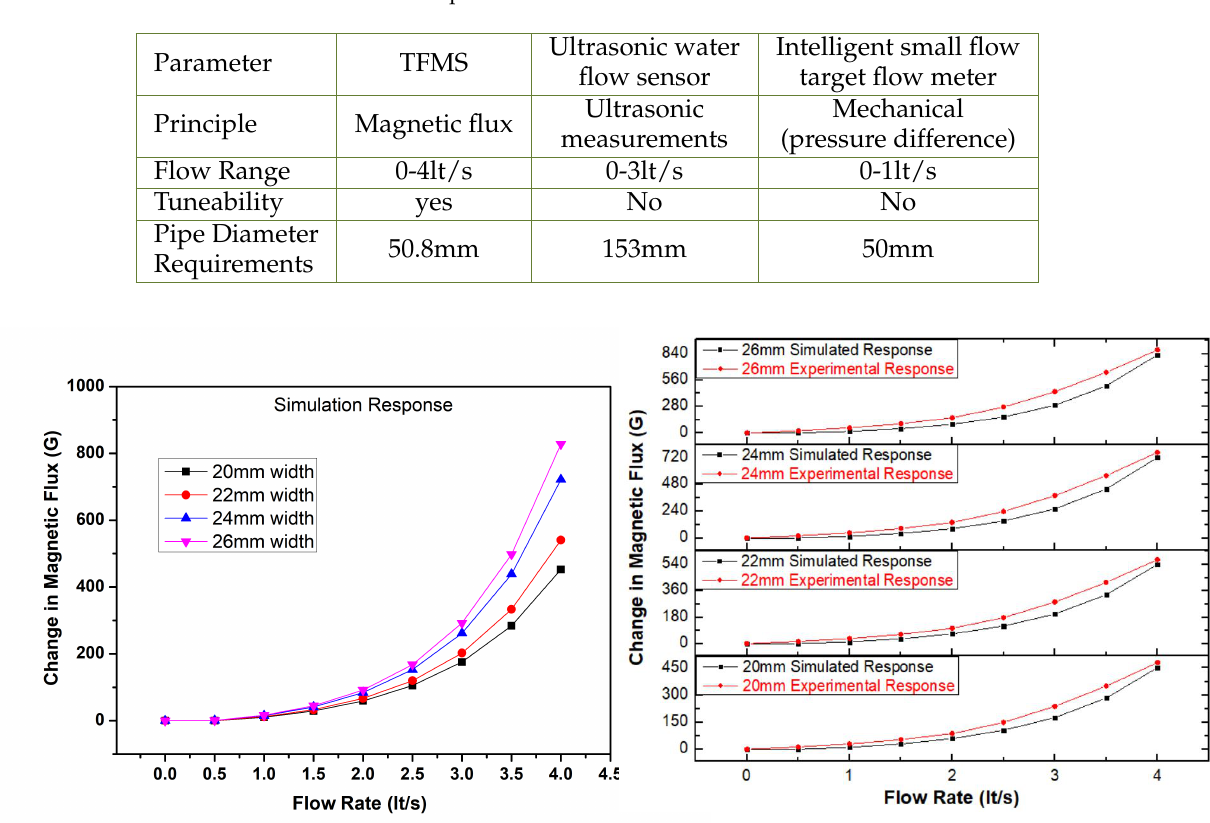
Table 3. Comparison of TFMS with similar flow meters